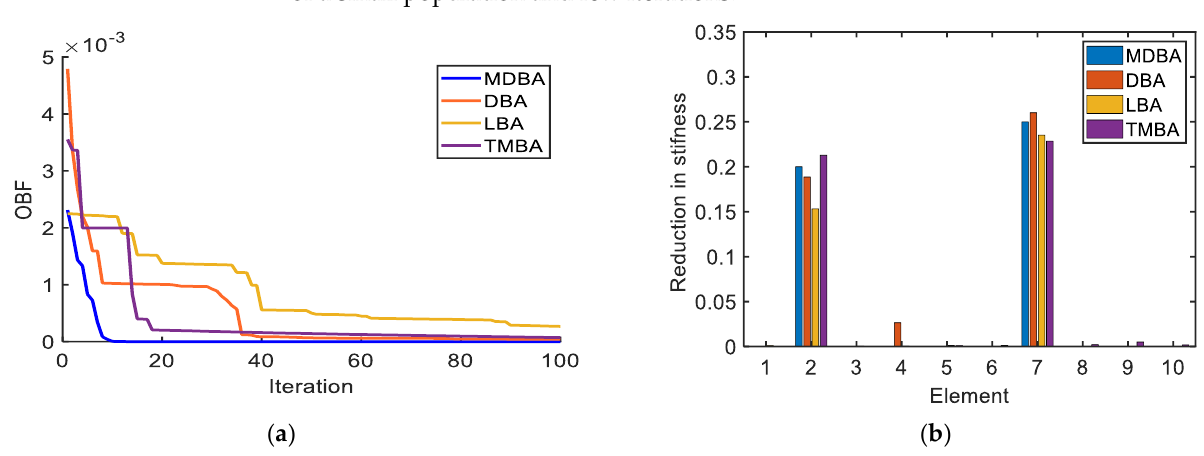
Figure 7. ( a ) The convergence curves achieved by other variations of BA for the objection function. ( b ) The identification results of the damaged case by other variations of BA. Table 2. The identification results of the damaged case by other variations of BA.